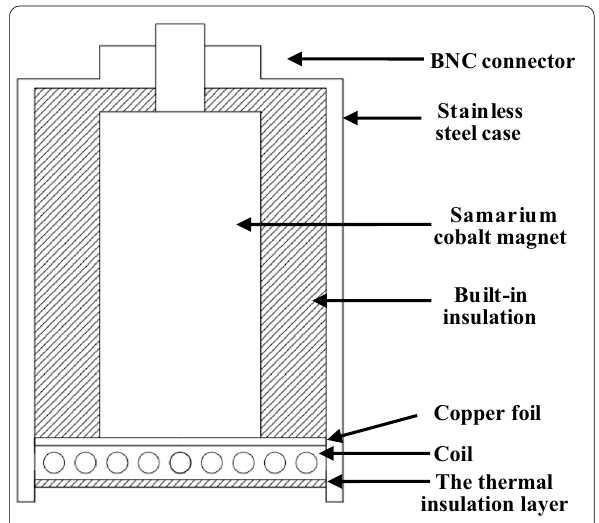
Figure 2 Structure of high-temperature